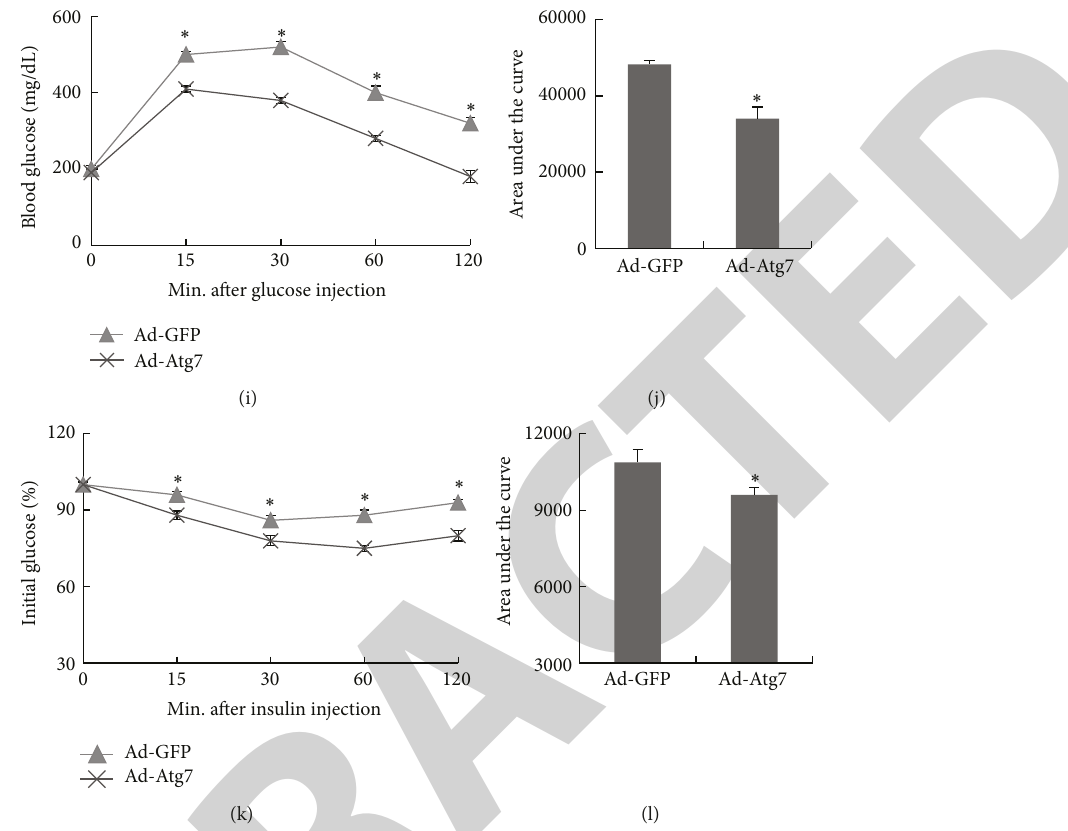
Figure 5: Improvement of ER stress and insulin signaling by the restoration of Atg7 in liver of obese mice. All analyses were performed in mice fed a high-fat diet (HFD) for 8 weeks and then adenovirus carrying Atg7 or GFP was delivered into obese mice via orbital venous plexus at a titer of 3 × 10 11 vp/mice. (a) Protein expression of Atg7, p62, and LC3 in liver. (b) The relative protein quantity of Atg7, p62, and LC3 in liver. (c) Quantification of autophagolysosome-like vacuoles per field in the EM images of liver (magnification 40000x). (d) Quantification of autophagolysosome-like vacuoles per field in the EM images of liver. (e) Phosphorylation of PERK and eIF2 𝛼 in liver. (f) The relative protein quantity of p-PERK and p-eIF2 𝛼 in liver. (g) Phosphorylation of IR and Akt in liver. (h) The relative protein quantity of p-IR and p-Akt in liver. (i) GTT. (j) Area under the curve by GTT. (k) ITT. (l) Area under the curve by ITT. The relative quantity of proteins was analyzed using Quantity One software. A representative blot is shown and the data was expressed as mean ± SEM in each bar graph. ∗ 𝑃 < 0.05 (HFD/Ad-Atg7 versus